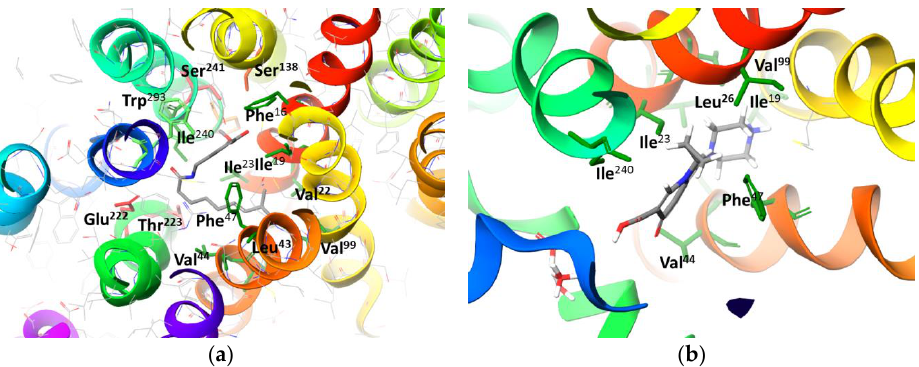
Figure 2. Molecular docking: ( a ) the NorA inhibitor capsaicin and ( b ) the NorA substrate ciprofloxacin. Residues are shown in grey (LeuVal, Phe, Ile, Trp), red (Glu), and orange (Thr, Ser). Figure was generated using the Schrödinger suite.